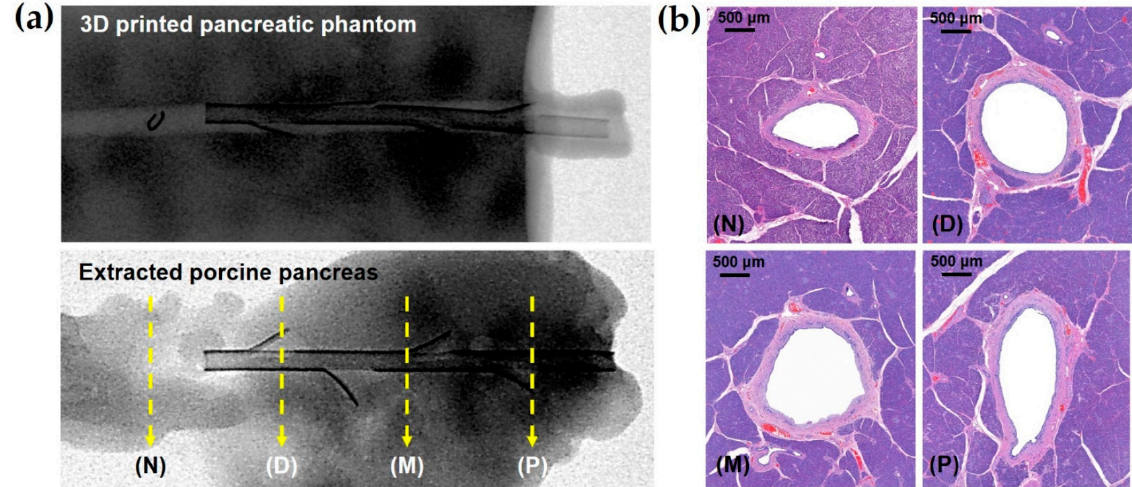
Figure 6. ( a ) Representative fluoroscopic images in type 3 obtained during the experiment in the 3D-printed pancreatic phantom and the extracted porcine pancreas and locations of tissue sampled for histologic examination where stent was present in proximal (P), middle (M), distal (D), and normal pancreatic duct without stent (N) portions. ( b ) Representative microscopic images (hematoxylin-eosin staining, magnification X2) in type 3 show no mucosal injuries in the stented p-duct (P, M, and